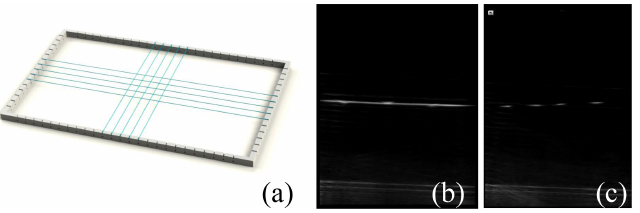
Figure 8. Validation wire phantom. ( a ) a supporting frame with crossing wires; ( b ) one of the US images intersecting with a transverse wire; ( c ) one of US images intersecting with longitudinal